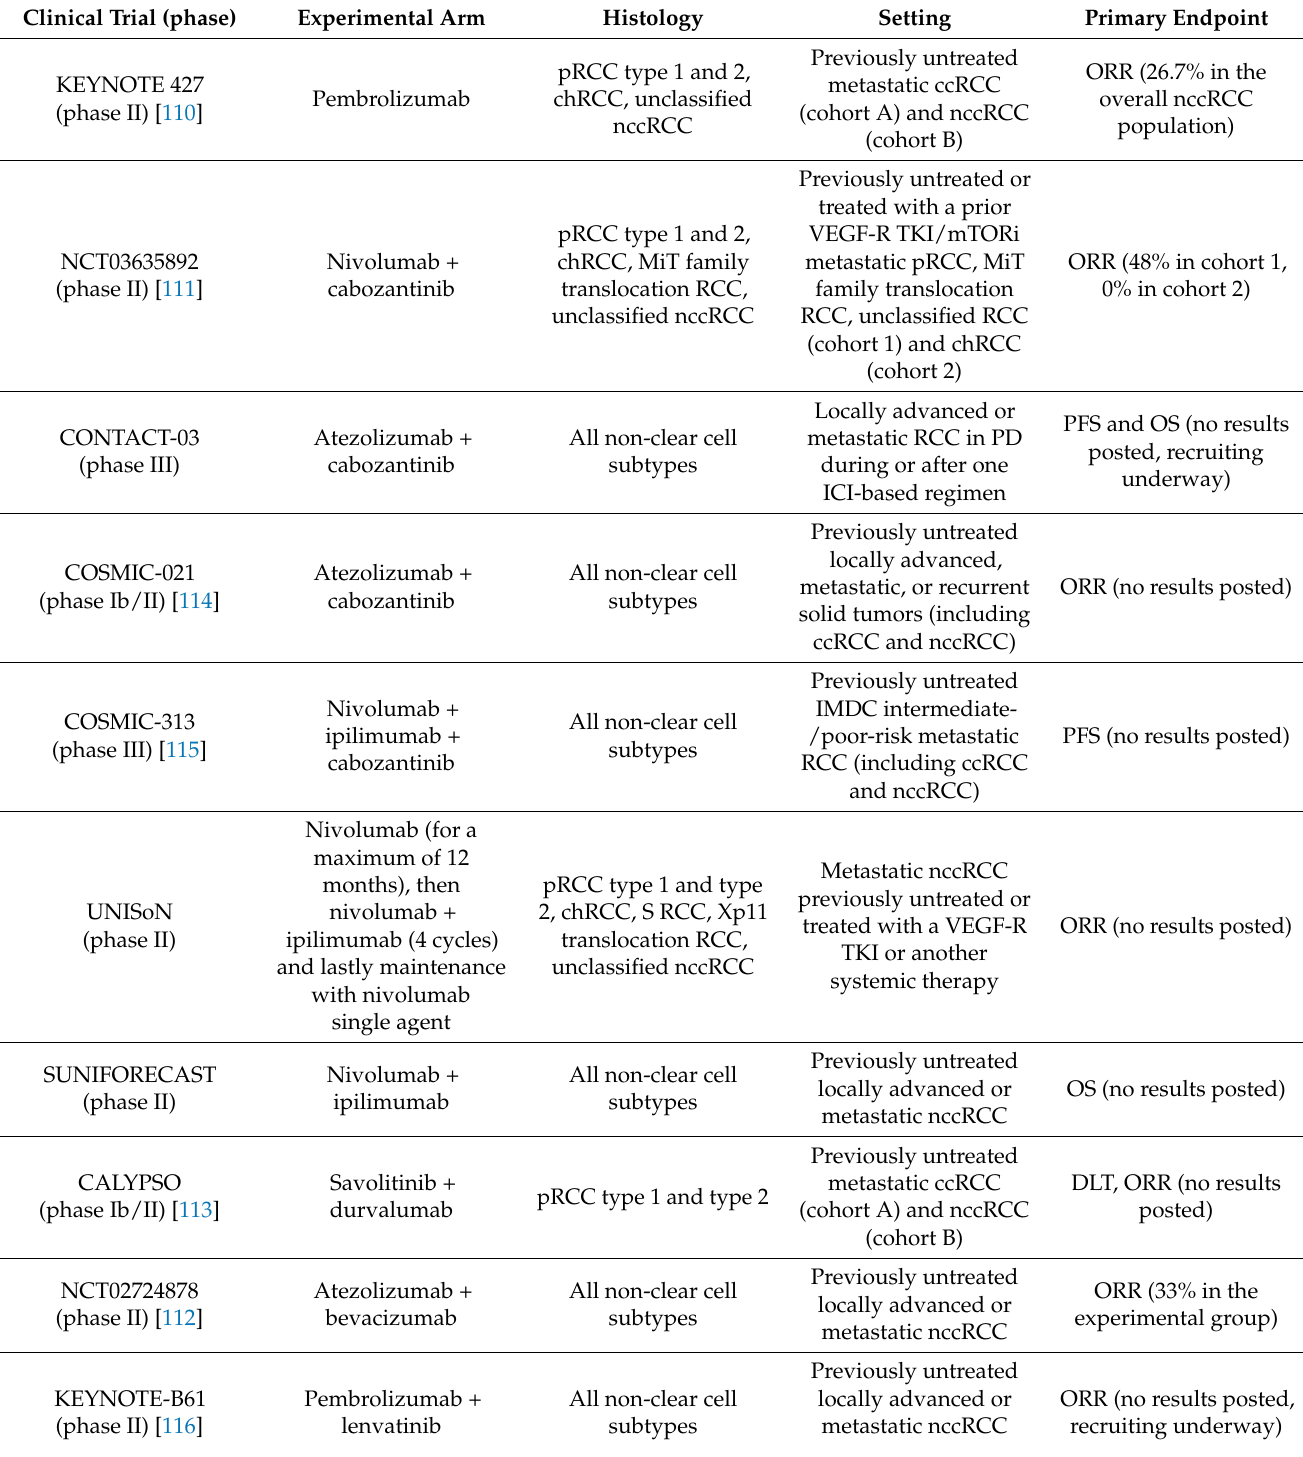
Table 3. A summary of the main published and ongoing phase II and III studies evaluating immunotherapies in non-clear cell